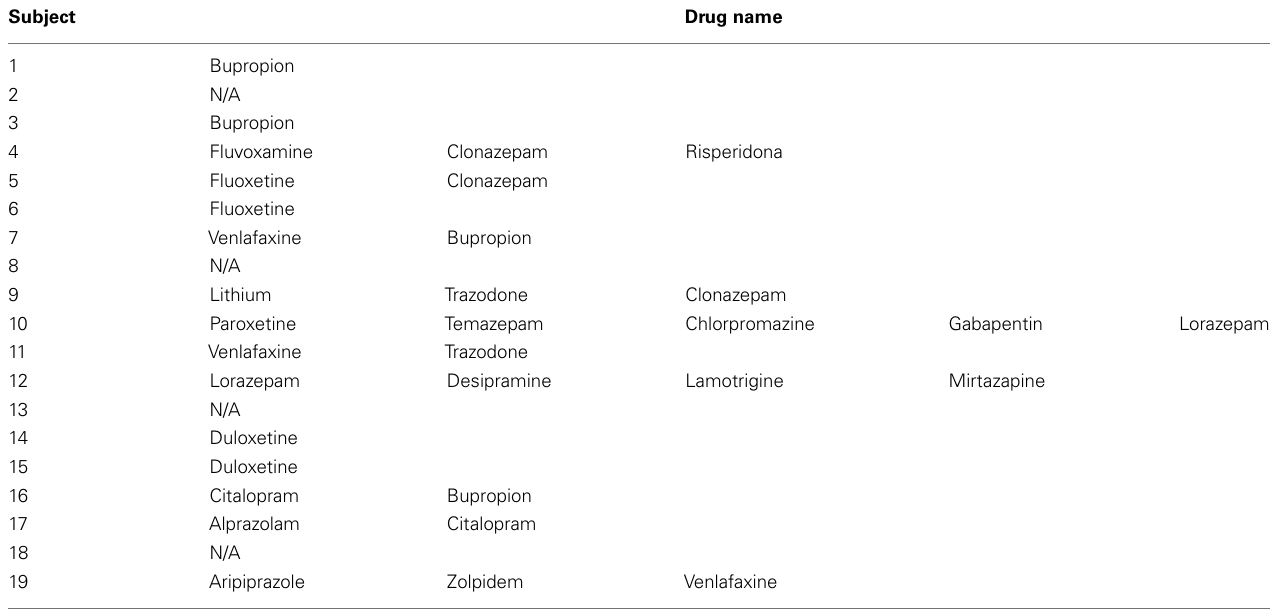
TableA1 | Descriptive list of medication for each individual with major depressive